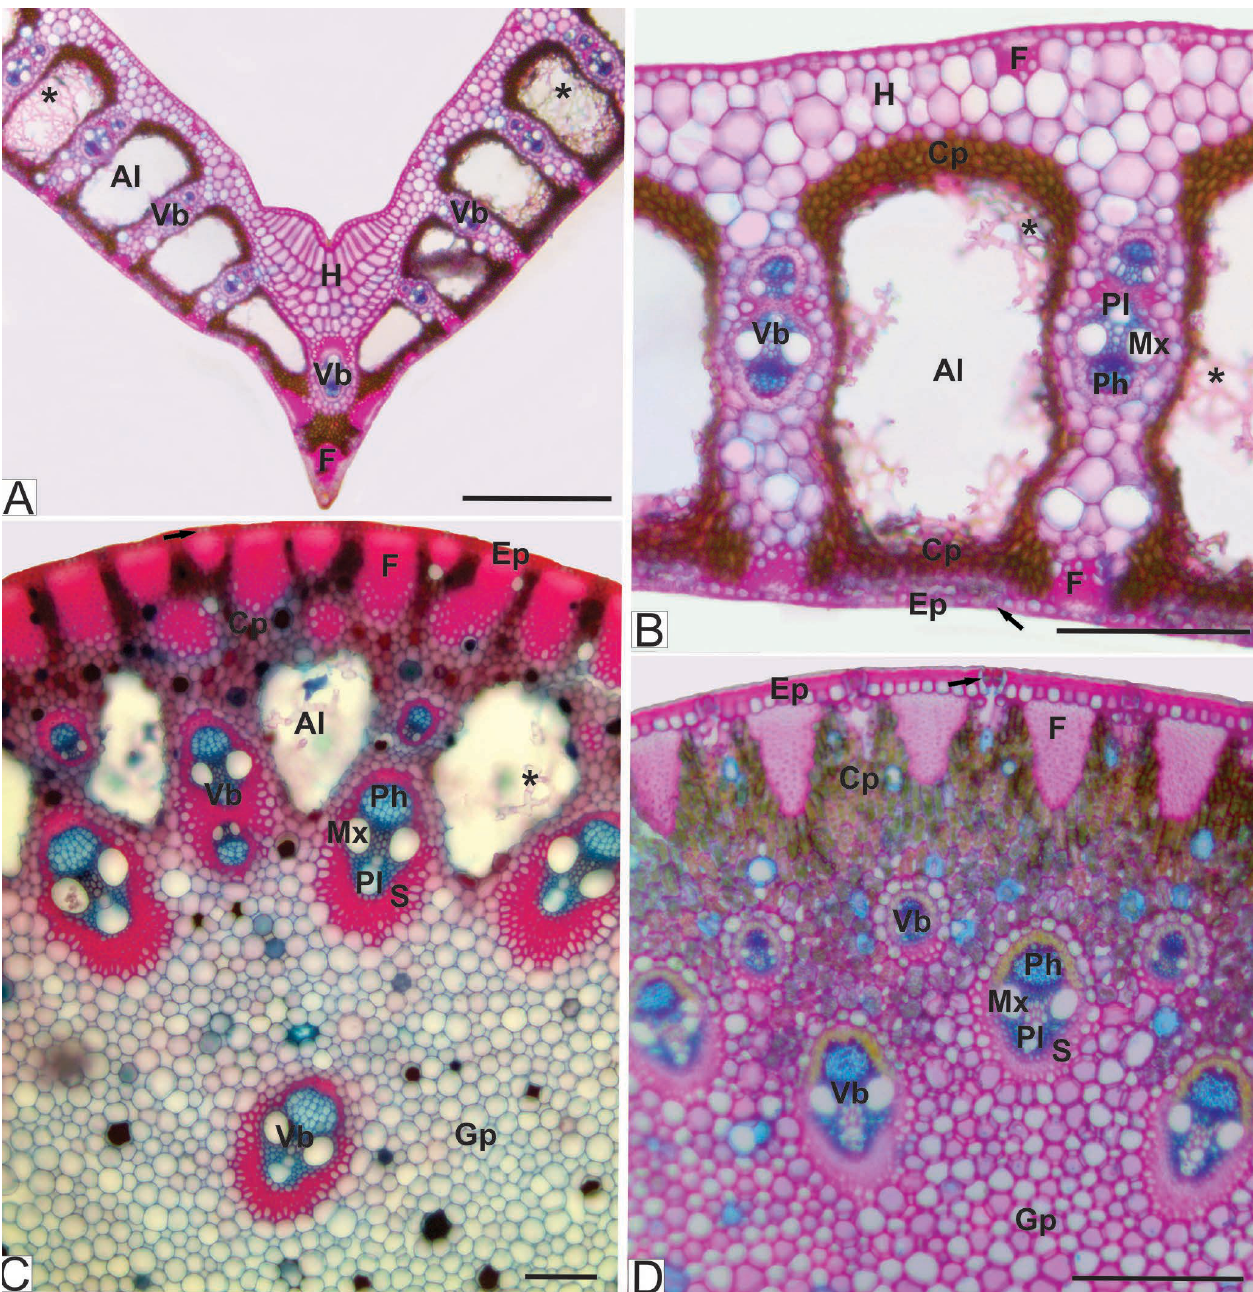
Figure 3 – Cross sections of Cyperus species. A – C . C. byssaceus . D . C. trigynus . A – B . Leaf. C – D . Culm. A . Midrib showing the hypodermis and large air cavities intercalated by the collateral vascular bundles. B . Detail showing the chlorophyll parenchyma surrounding the air cavities. C . Strongly thickened subepidermal fibres and air cavities. D . Epidermis with thickened walls, subepidermal fibres, and collateral vascular bundles. The analysed organs do not have Kranz anatomy. Ac – air cavity; Cp – chlorophyll parenchyma; Ep – epidermis; F –